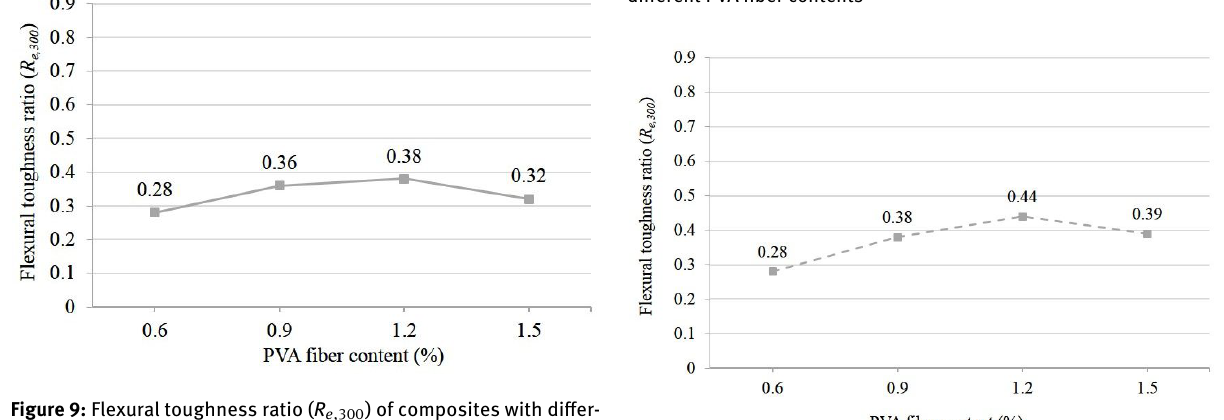
Figure 9: Flexural toughness ratio ( R e ,300 ) of composites with differ- ent PVA fiber contents